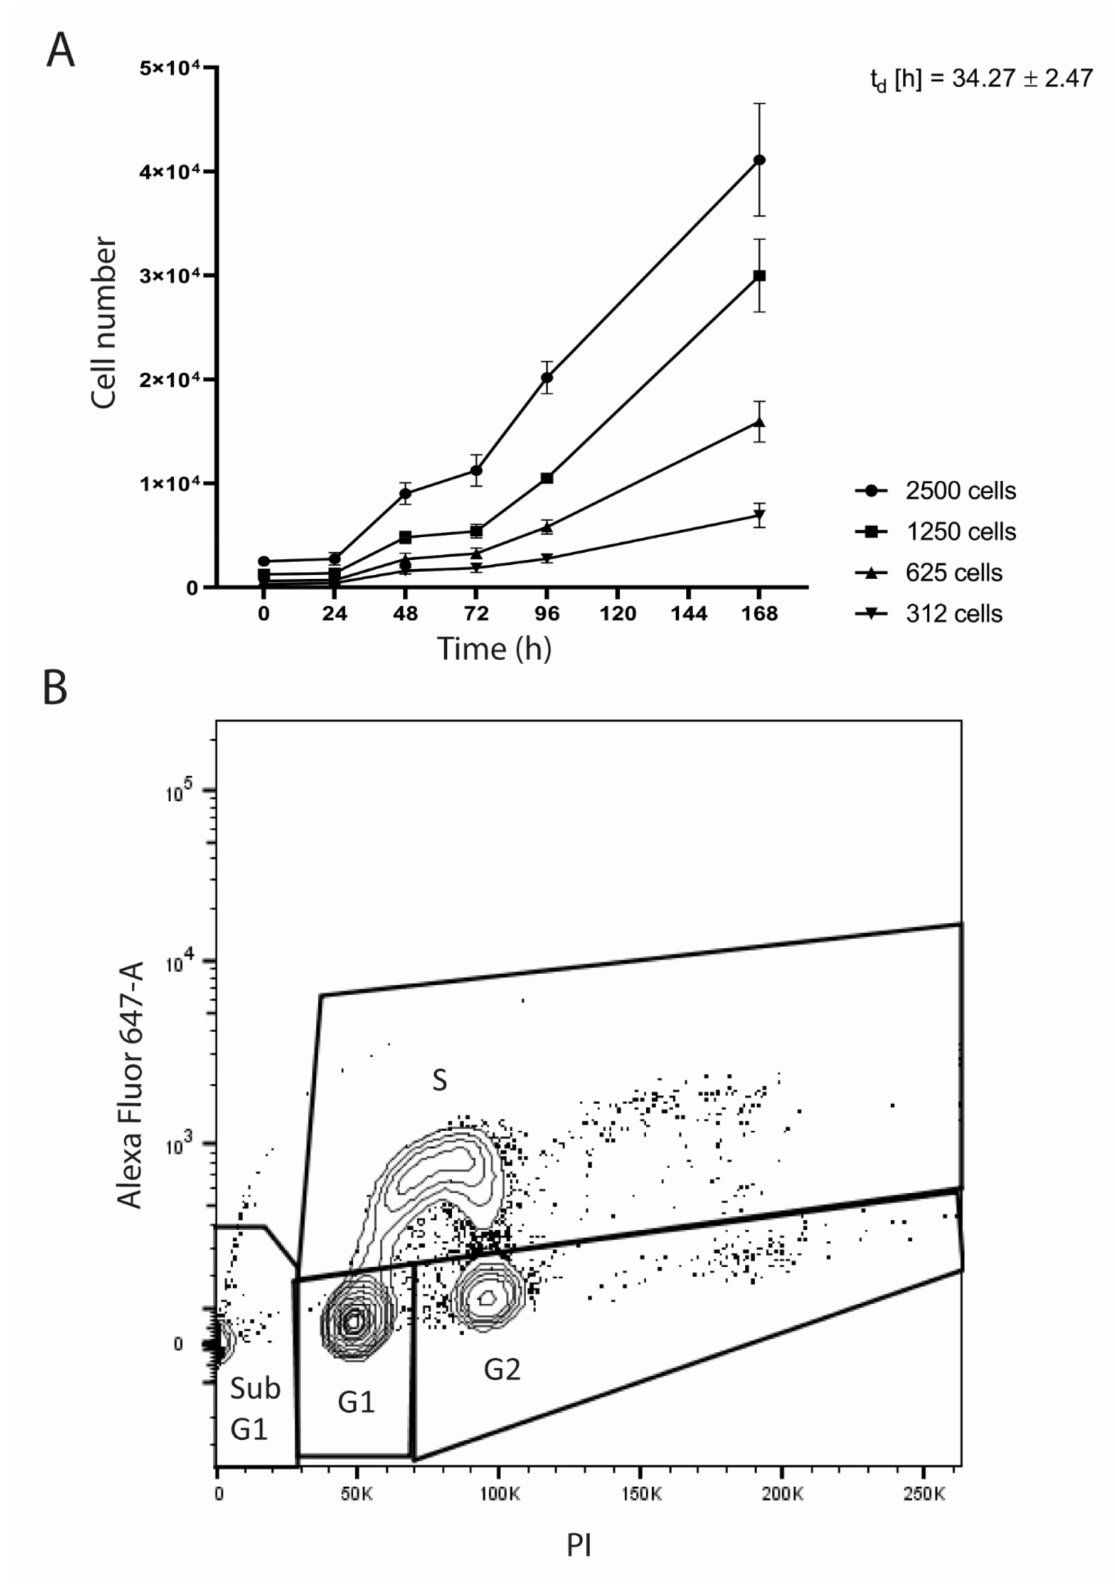
Figure 3. SRH proliferation characteristics. ( A ) Growth curves were determined over a period of 168 h (h) after seeding of 312, 625, 1250 or 2500 SRH cells and the cell population doubling time (t d ) was calculated. ( B ) Cell cycle (EdU Alexa Fluor 647-A) and DNA ploidy (PI) analysis was performed by flow cytometry. Distribution of the cells in the di ff erent cell cycle phases sub G1, G1, G2, and S was